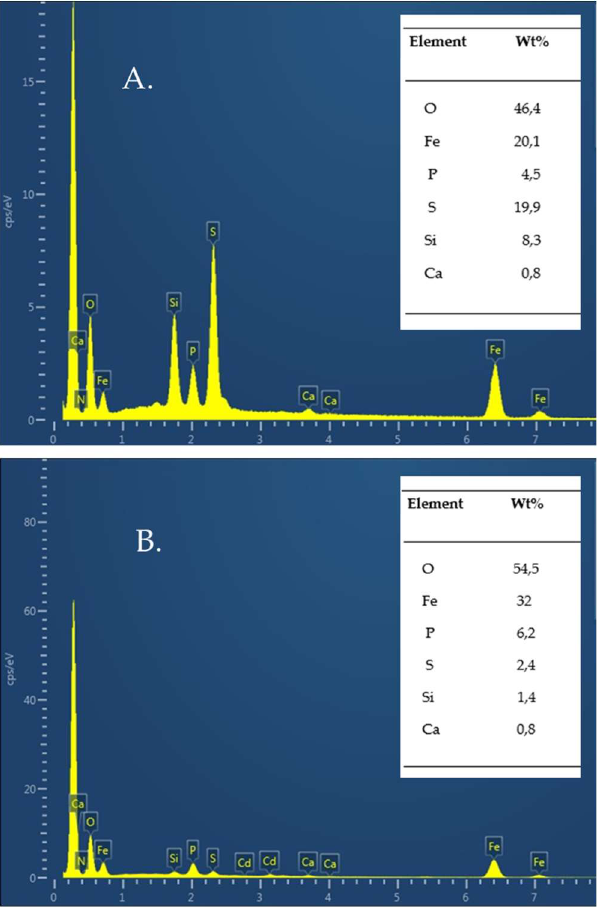
Figure 6. Energy-dispersive X-ray spectra (EDX) of hollow fibers incubated with enriched IC sludge samples. ( A ) Sample (a) IC sludge and NaHCO 3 . ( B ) Sample (b) IC sludge and C 2 H 3 NaO 2 . Magnifi- cation: 10,000×.